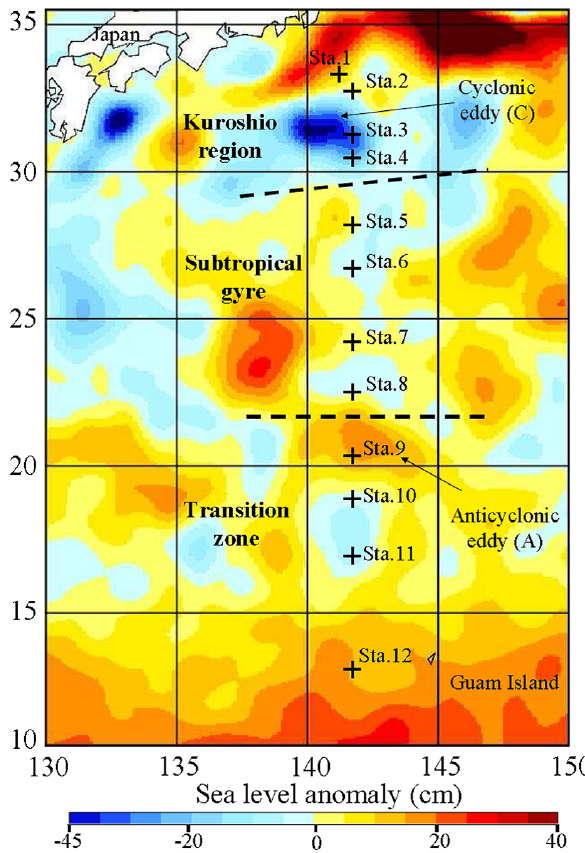
Figure 1. Map of the sea level anomaly (cm) in the west part of the North Pacific subtropical gyre. The sampling stations (black crosses) were separated depending on temperature and salinity into 3 areas: Kuroshio region (Stations 1–4), subtropical gyre (Sta- tions 5–8) and the transition zone (Stations